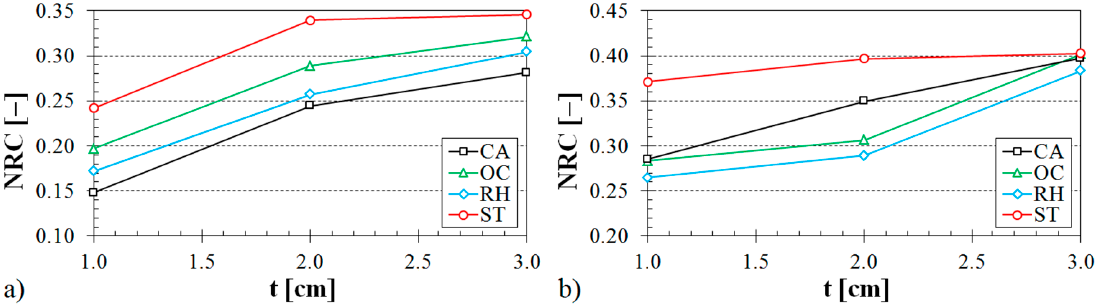
Figure 11. Influence of the 3D-printed ABS material structure on the noise reduction coefficient vs. material thickness for the investigated ABS samples: ( a ) volume ratio V r = 44%, air space size a = 10 cm; ( b ) volume ratio V r = 70%, air space size a = 4 cm. Materials 2020 , 13 , x FOR PEER REVIEW